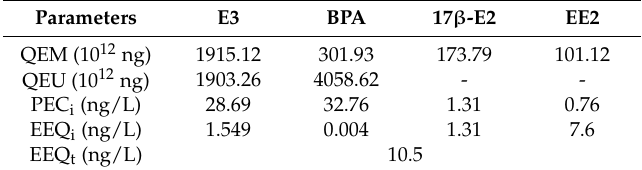
Table 7. The predicted environment concentration of estrogens in the water in Jiangsu Province. Parameters E3 BPA 17 β -E2 EE2 QEM (10 12 ng) 1915.12 301.93 173.79 1903.26 4058.62 - - PEC i (ng/L) 28.69 32.76 1.549 0.004 10.5